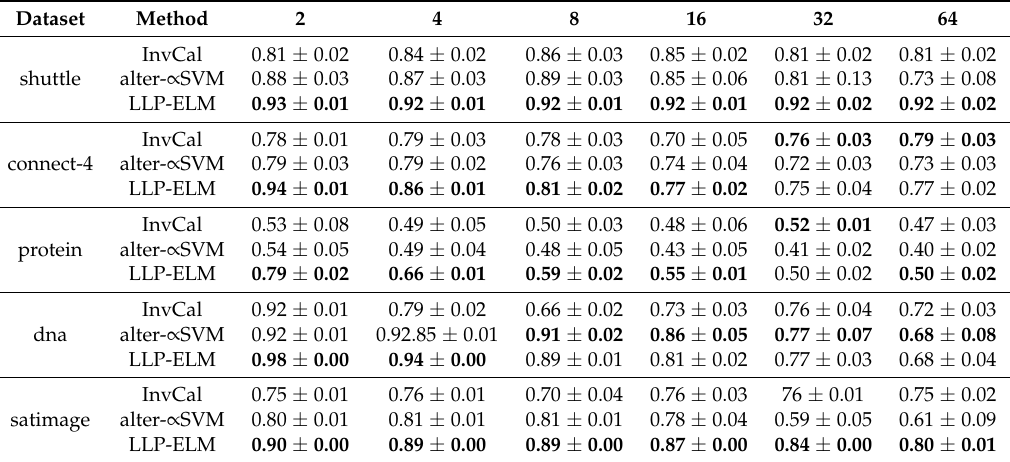
Table 5. The final results under the optimal parameters with bag size 2, 4, 8, 16, 32, 64 on multi-class datasets. Bold numbers denote the best accuracies.